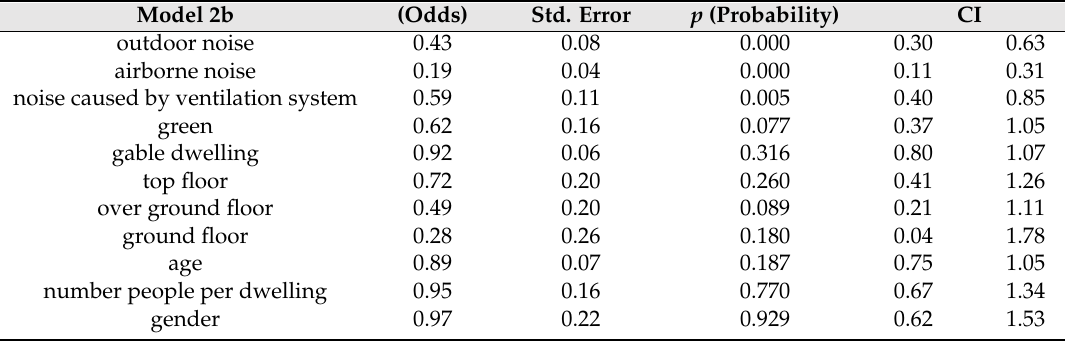
Table 13. Model 2b, ordinary logistic model describing relationship between satisfaction of indoor acoustic quality and perceived frequency of experienced problems; N = 393, pseudo R-squared =